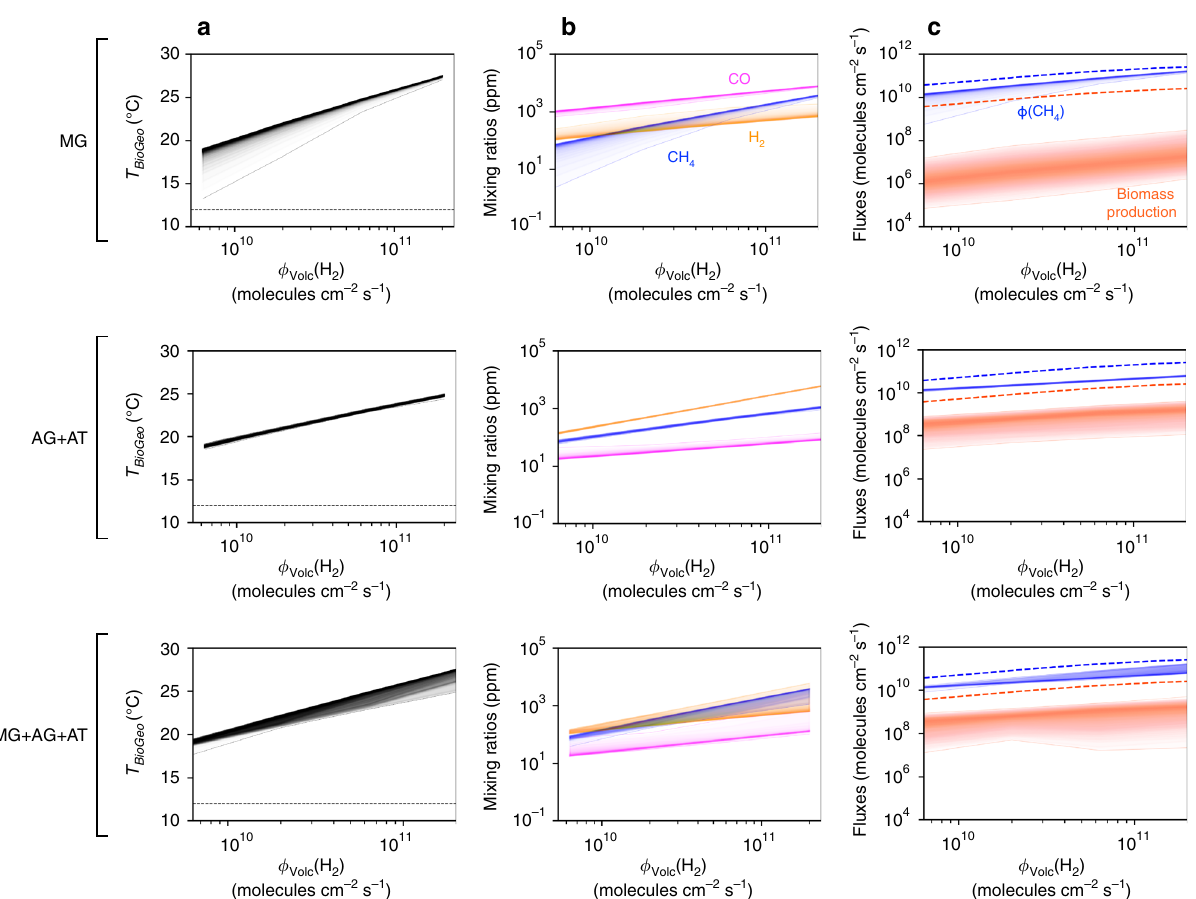
Fig. 2 Short-term biological feedback to the atmosphere and climate. Effects are computed as a function of the H2 volcanic outgassing, for each ecosystem composition. MG indicates H 2 -based methanogens (MG). AG + AT indicates CO-based acetogens and methanogenic acetotrophs consortia. MG + AG + AT indicates co-occurring methanogens, acetogens, and acetotrophs. a Global surface temperature at ecosystem-climate equilibrium. The dotted line indicates the initial abiotic surface temperature, T Geo = 12 °C. b Atmospheric composition at ecosystem-climate equilibrium. c Biogenic fl uxes at ecosystem-climate equilibrium: CH 4 production and carbon fi xation in biomass (in molecules of C cm − 2 s − 1 ). Envelopes represent probability distributions from Monte-Carlo simulations across the biological parameter space, with each layer indicating output frequency ranging from 90 to 51%. Predictions from ref. 13 are also shown (dashed) for comparison. See “ Methods ” and Supplementary Tables 3 and 4 for parameter